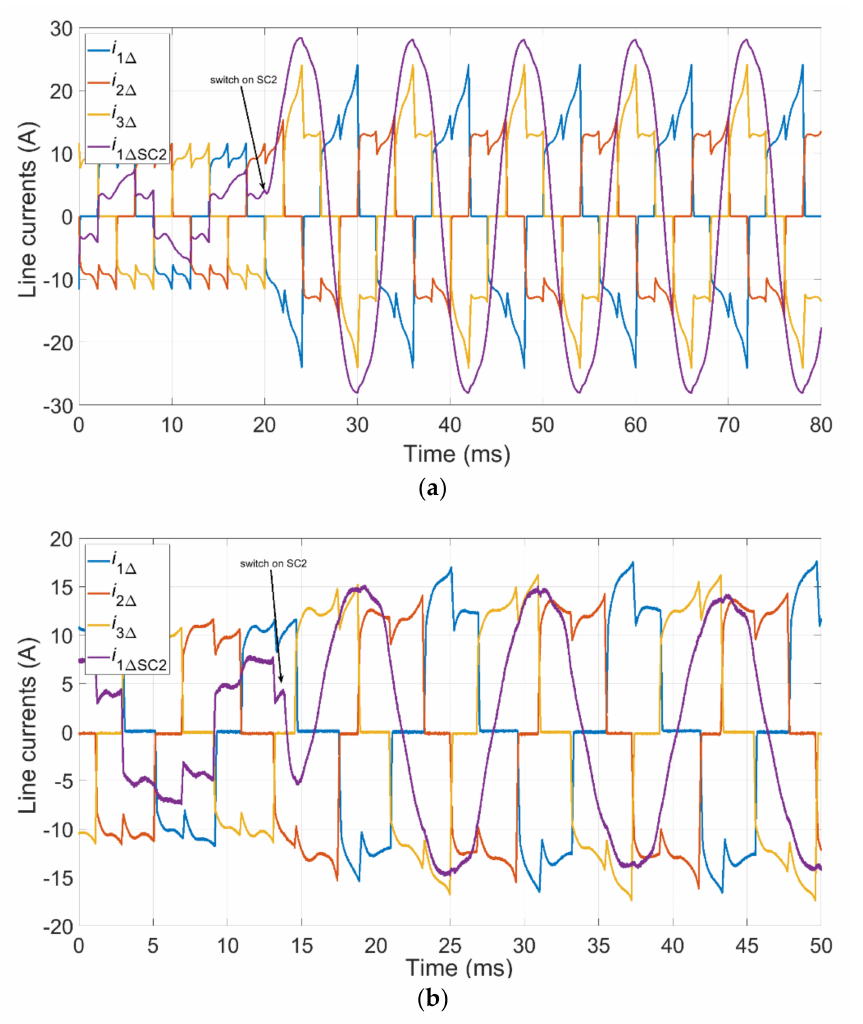
Figure 9. (cid:52) configuration—waveforms of line currents—healthy to SC2 ( a ) numerical calculations; ( b ) laboratory